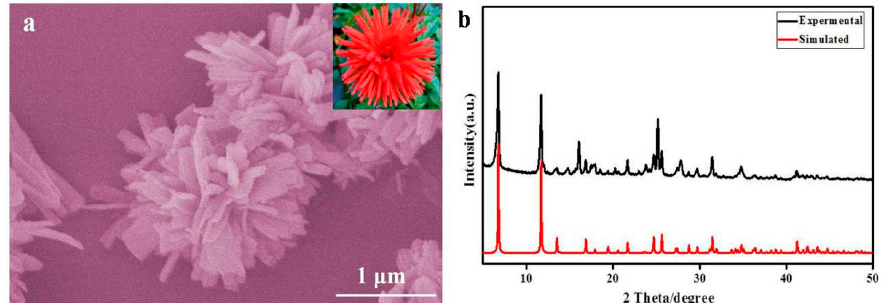
Figure 6. SEM images ( a ) and XRD ( b ) of Ni-Co/BDC MOF microparticles fabricated in the solvent of the ternary mixture. The structure of the simulated 3D reference was shown in Figure S4.